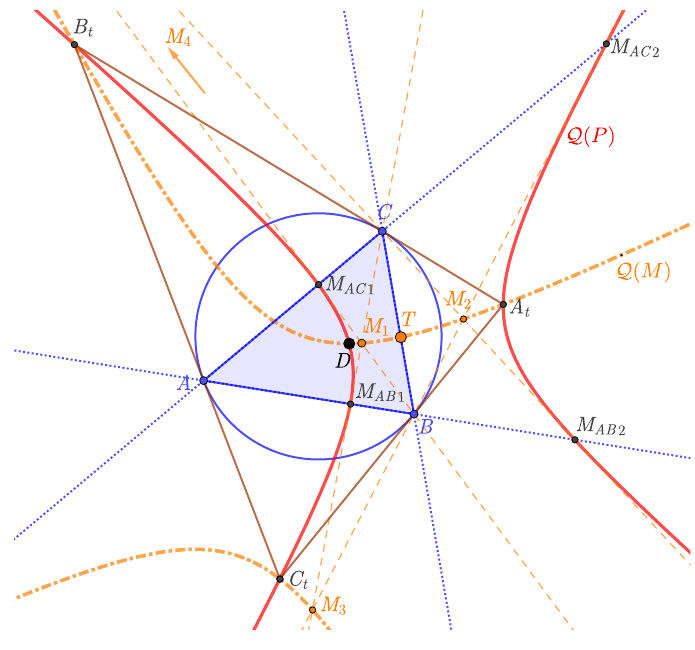
Figure 8. Tangent lines at intersection